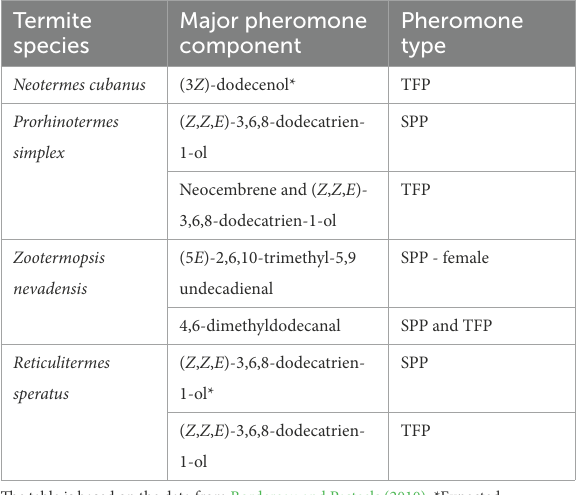
The table is based on the data from Bordereau and Pasteels (2010). *Expected component – based on the pheromone composition reported from congeneric species (Bordereau and Pasteels,